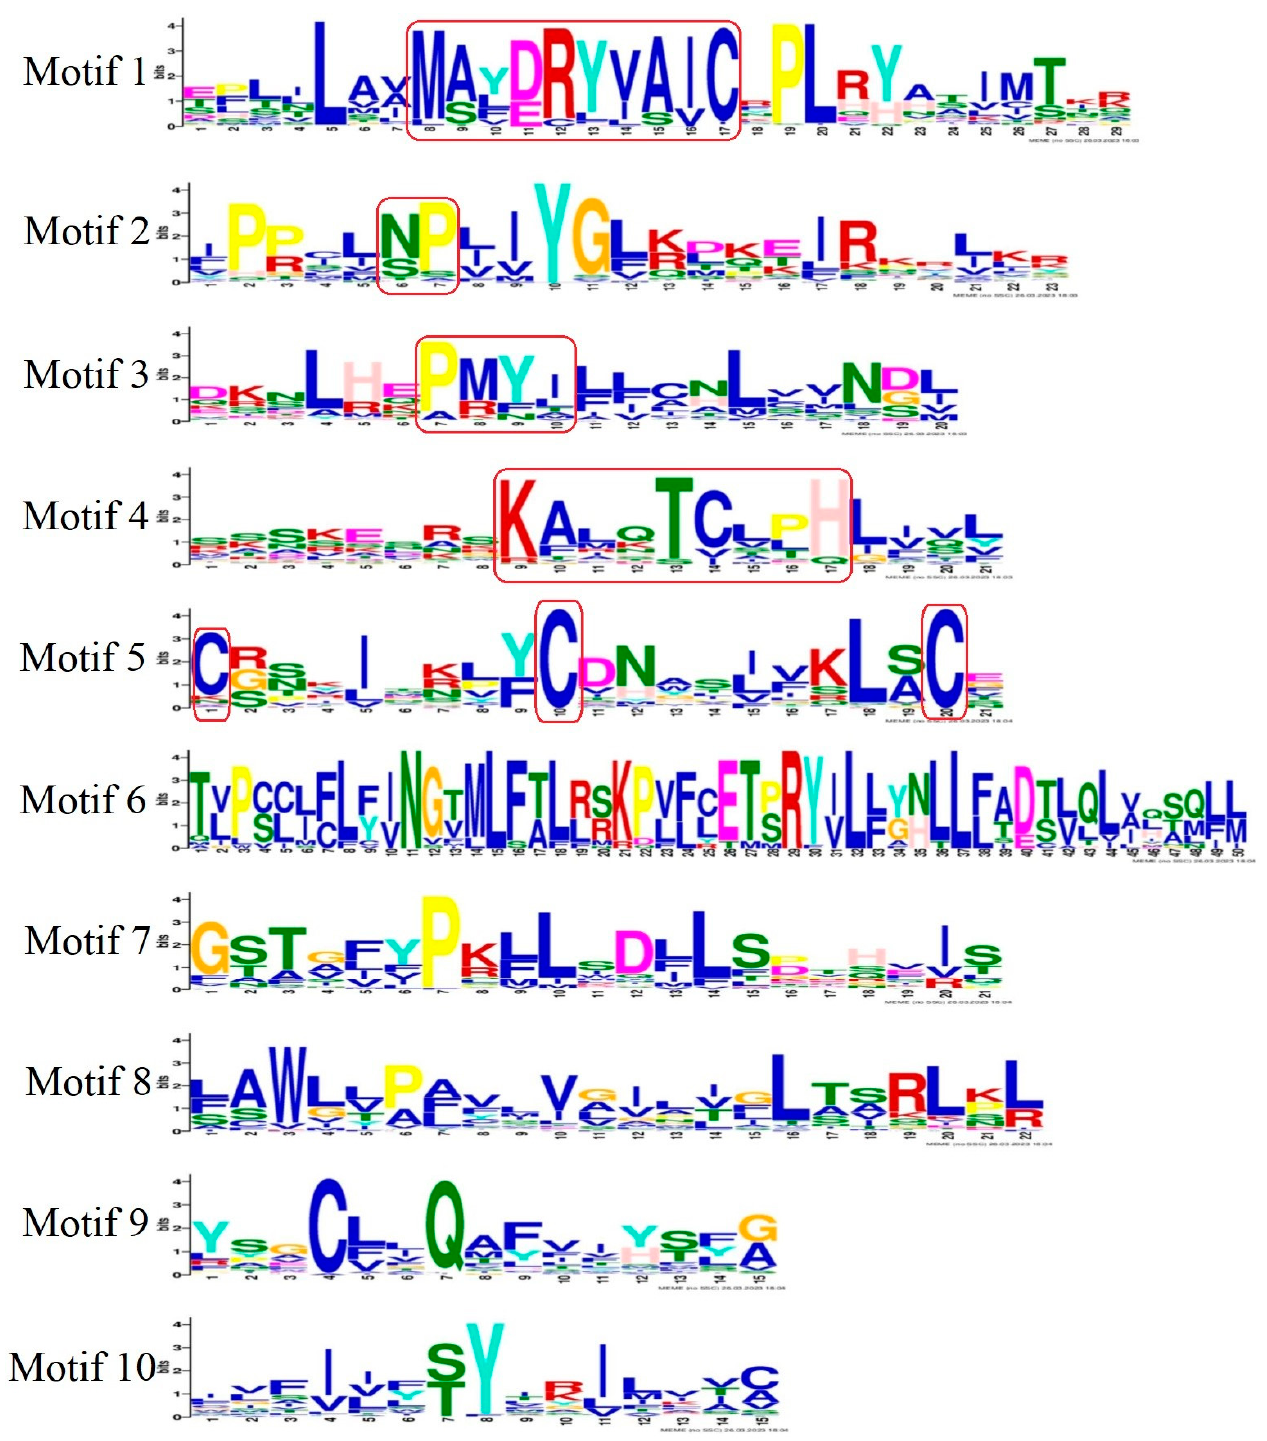
Figure 3. Logo representation of the 10 best-conserved motifs in OR genes. The height of the amino acid code represents the conserved degree of the motifs. The height of the letters in the logo indicates the relative frequency of amino acid occurrence, and is proportional to the level of sequence conservation. The sequence outlined by red rectangles was a functionally conserved motif in motifs 1, 2, 3, 4, and 5.